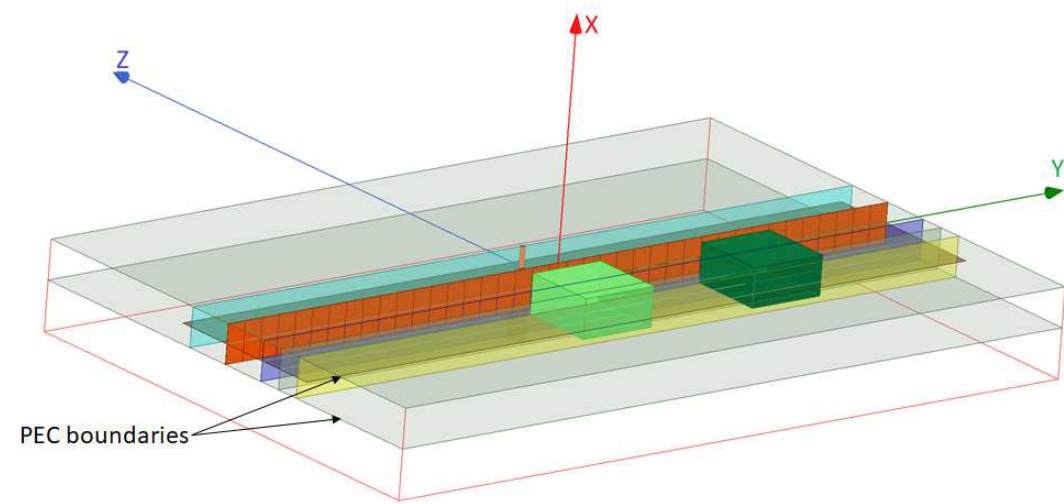
Figure 5. The simulated NF plate setup. The NF plate (orange plane), introduced in [47], is excited from the back by the inner conductor (orange cylinder) of a coaxial cable which lies on the excitation plane (light blue plane). This structure then illuminates the OI (light green dielectric box) and the undesired scatterer (dark green dielectric box). The dark blue and yellow planes show the focal plane and the receivers’ plane respectively. The two dielectric boxes have the same size of λ /20 × λ /10 × λ /10 along x -, y -, and z -directions, and have the same relative permittivity.